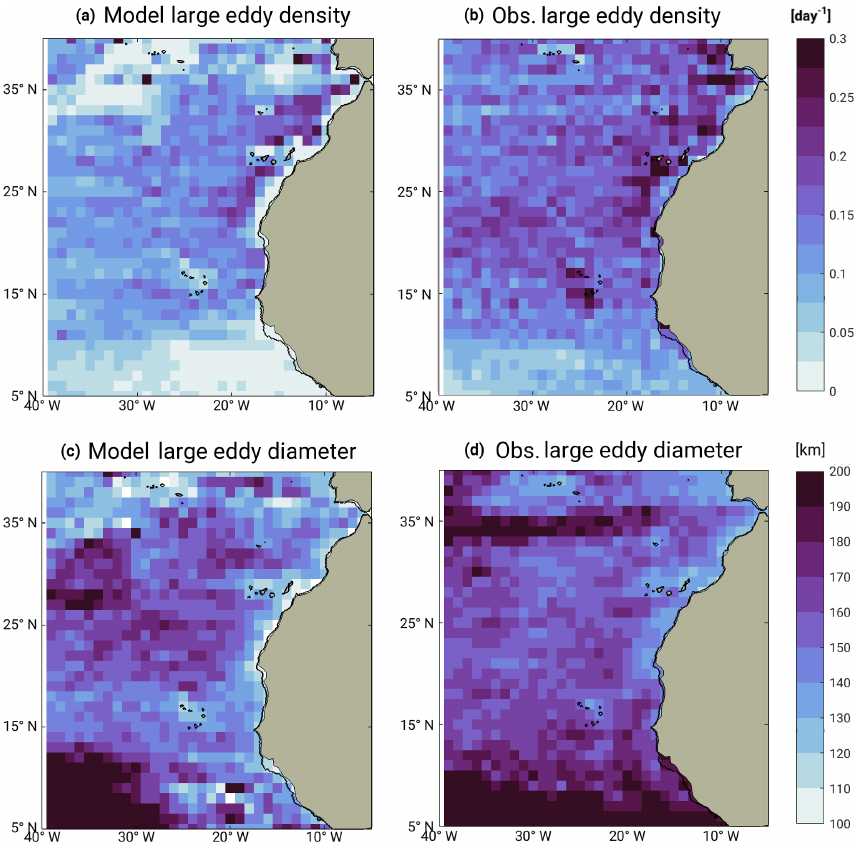
Figure 3. Comparison of the mean number of large eddy ( R ≥ 50km) centroids from (a) modeled ROMS and (b) observed AVISO, binned to 1 ◦ × 1 ◦ bins. Comparison of the mean diameter [km] of large eddies ( R ≥ 50km) from (c) modeled ROMS and (d) observed AVISO, binned to 1 ◦ × 1 ◦